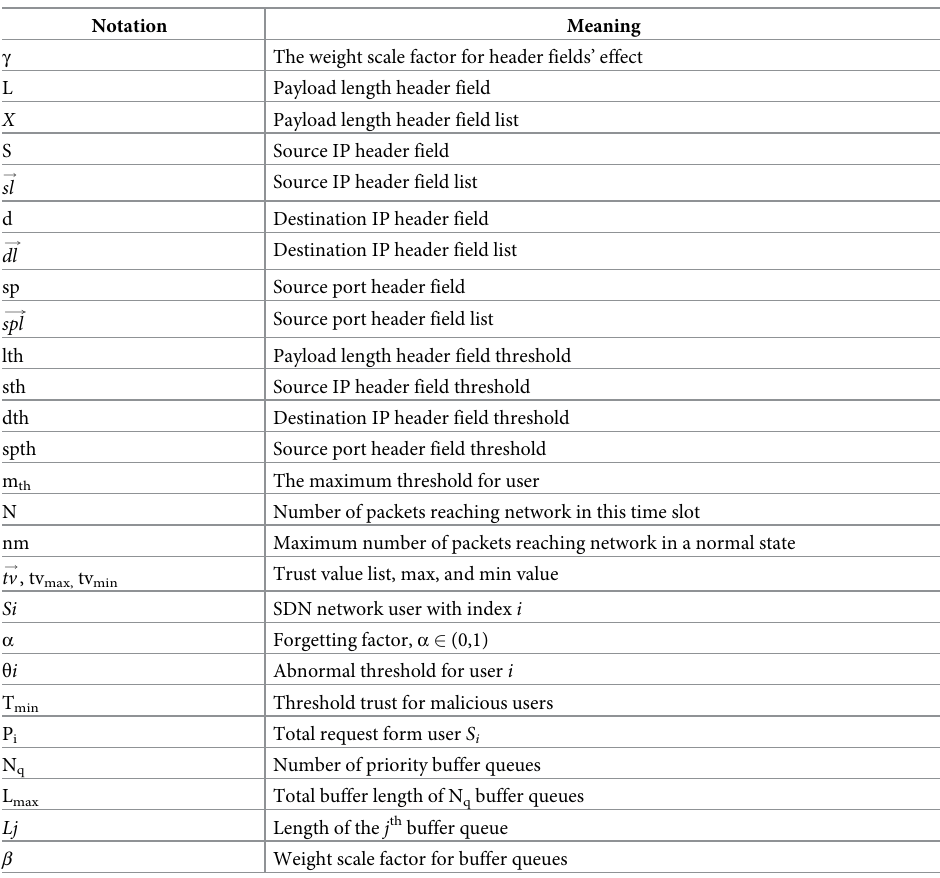
Table 2. List of notations.